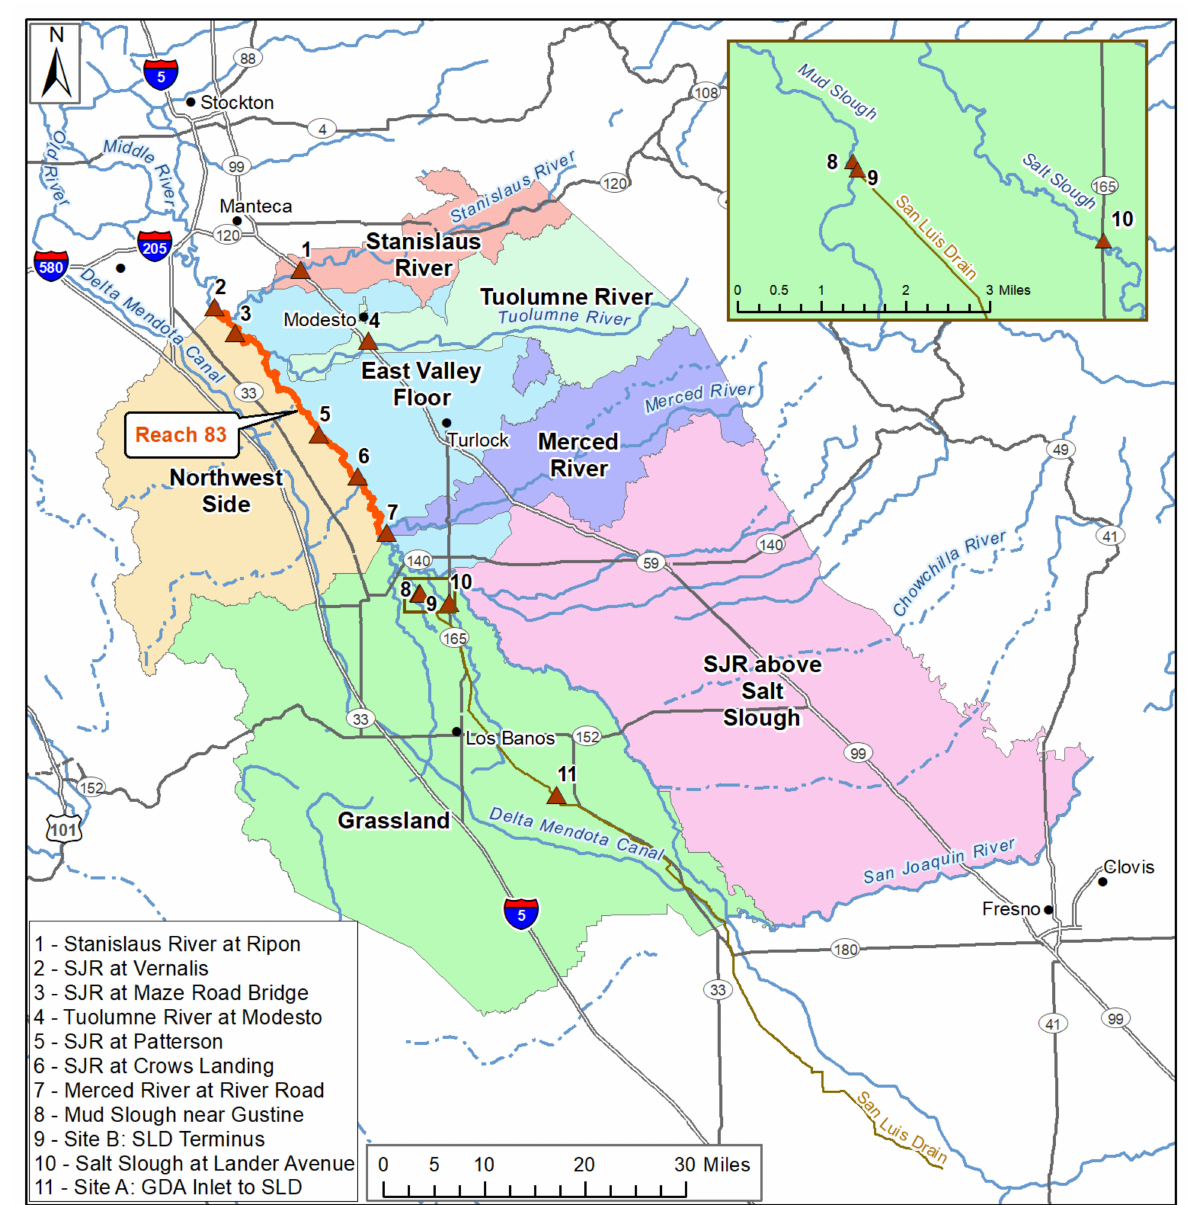
Figure 1. Major subareas within the SJR Basin that drain to the SJR as defined in the salinity TMDL [13]. Reach 83 shown in the figure is the reach for which water quality (salinity) is regulated through the recognition of three compliance monitoring stations at Crows Landing, Maze Road Bridge and Vernalis. The most salient feature of the SJR Basin is that drainage from sources to the west of the SJR are elevated in salinity by virtue of native salts in alluvial sediments deposited from the coastal range mountains west of the Valley floor and the importation of irrigation water supply from the Sacramento-San Joaquin Delta that is also salt impacted. Tributary inflow from land areas to the east of the SJR are of high quality, derived from snowmelt from the Sierra Nevada mountains. Real-time management is essentially a scheduling activity—coordinating salt load assimilative capacity consumed by west-side saline drainage with salt load assimilative capacity supplied by east-side reservoir releases along the major